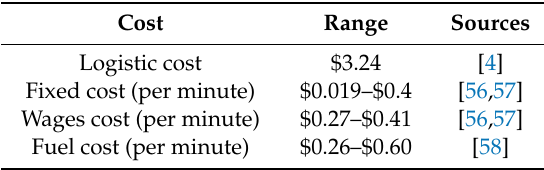
Figure 2. The location and selected factors of the case study in Missouri: ( A ) Case study location; ( B ) Growing season temperature; ( C ) Annual precipitation; ( D ) Terrace slope; ( E ) Critical habitats; ( F ) Soil texture; ( G ) Land use land cover. Table 4. Cost of transportation. Including locally normalized costs for loading, unloading and storage per load and ranges for fuel, wages and equipment in the study